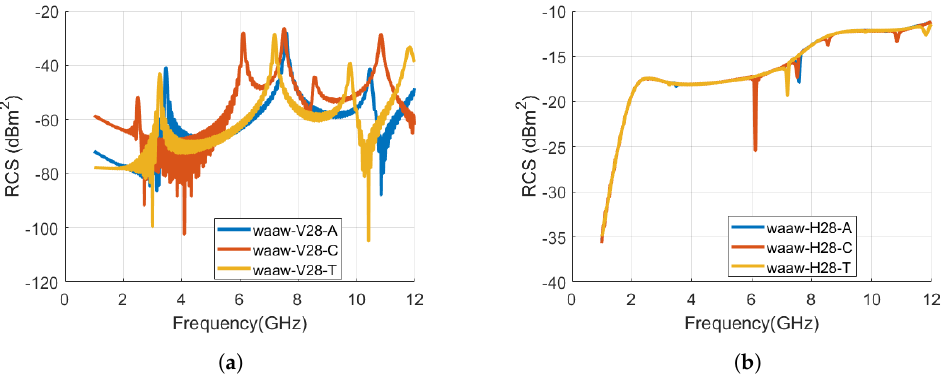
Figure 16. Comparison of RCS results of alphabet (cid:240) tag with various font types (Arial, Calibri, and Times New Roman) with the font size of 28: ( a ) Vertical polarization; ( b ) Horizontal polarization. Table 5. Signature resonance frequencies for letter (cid:240) tag with various font types (Arial, Calibri, and Times New Roman) with the font size of 28.